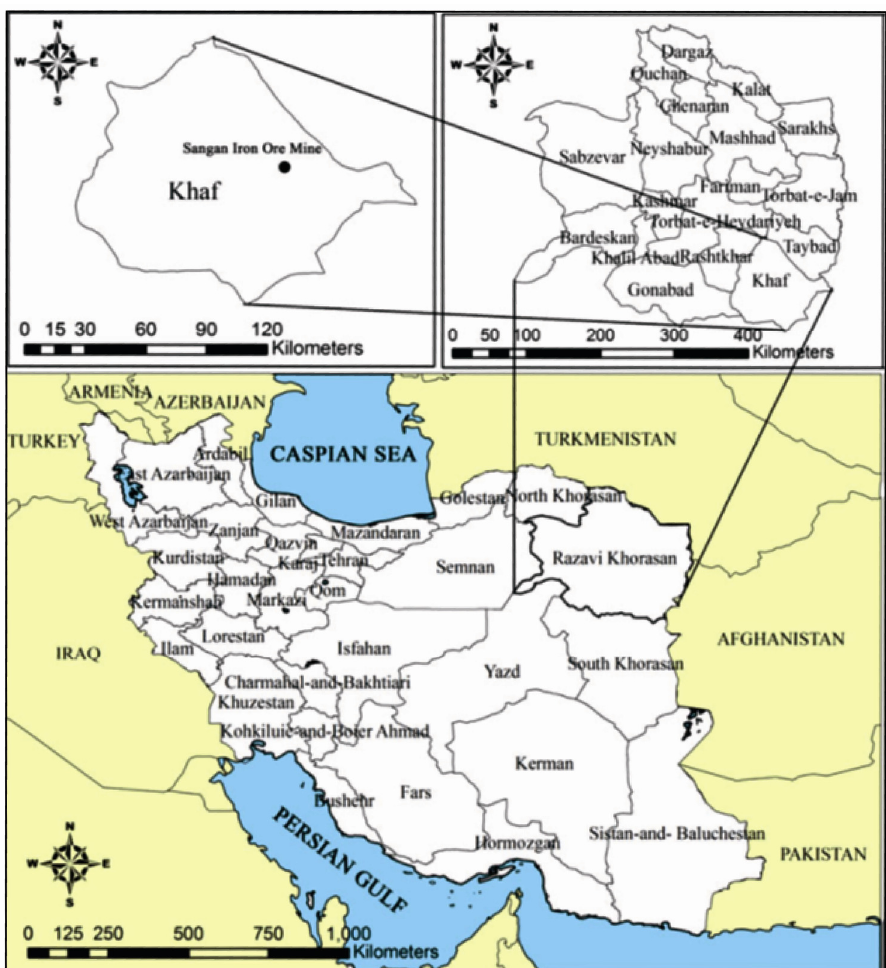
Fig. 4. Geography of Sangan iron mine (Naghizadeh et al .